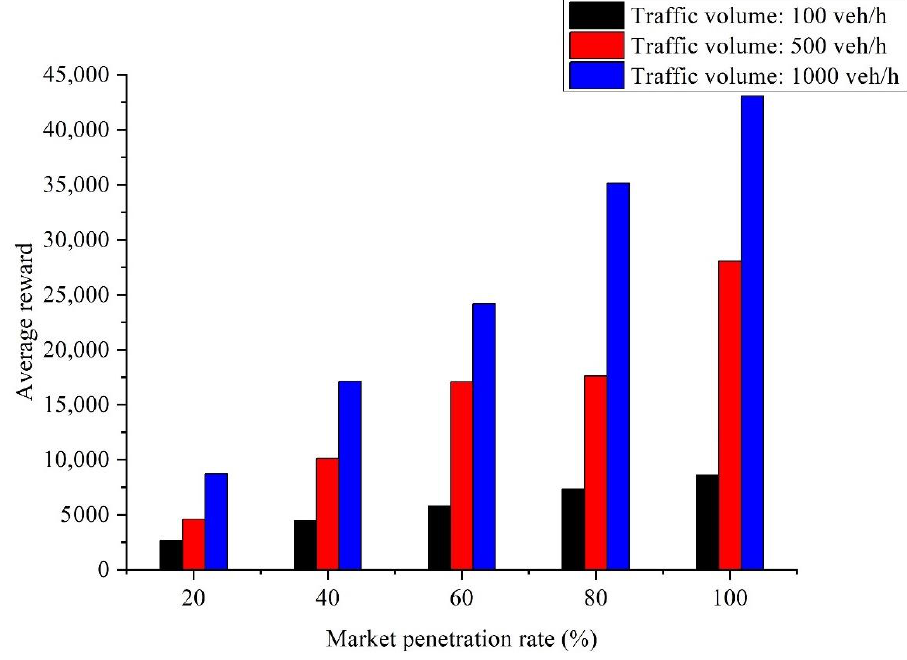
Figure 7. Average rewards with different market penetration rates and real traffic volumes.